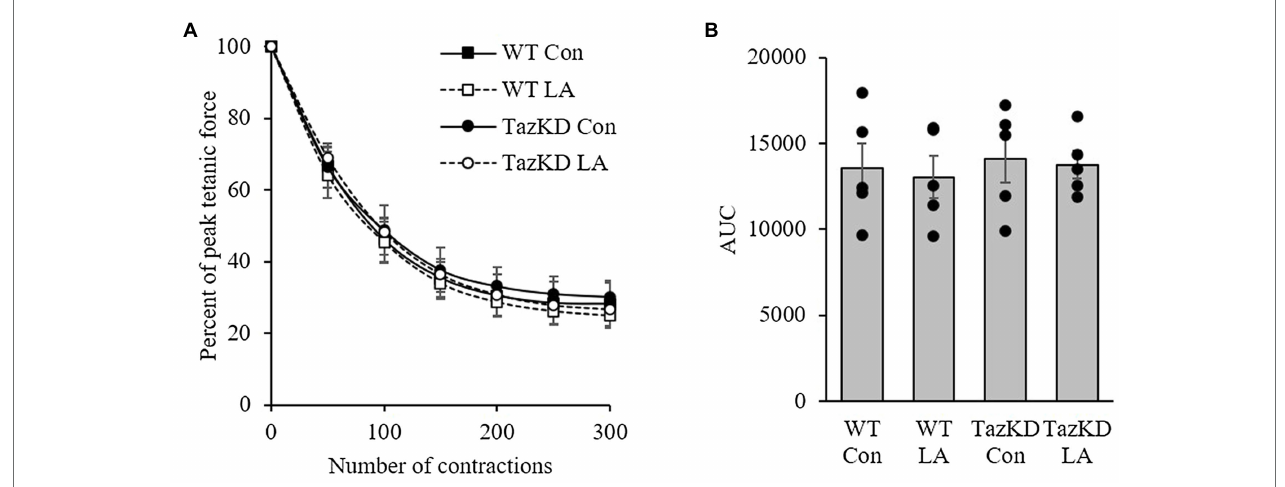
FIGURE 6 | 8 weeks of supplemental linoleic acid diet did not influence soleus fatigability expressed as (A) percent peak tetanic force and (B) area under the curve in TazKD male mice, or their wild-type littermates compared to the control chow diet. Values are means ± SEM, n = 5. WT, wild type; TazKD, tafazzin knockdown; Con, chow diet; and LA, linoleic acid-supplemented diet.